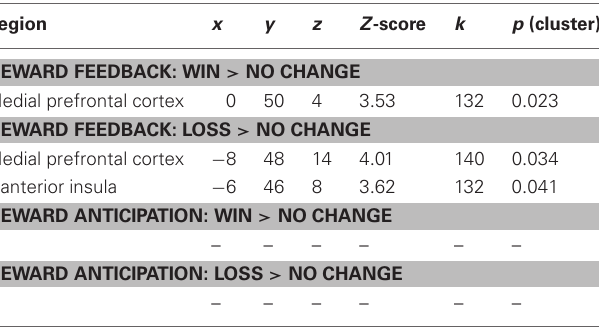
Table 2 | Brain regions showing an association with PSS